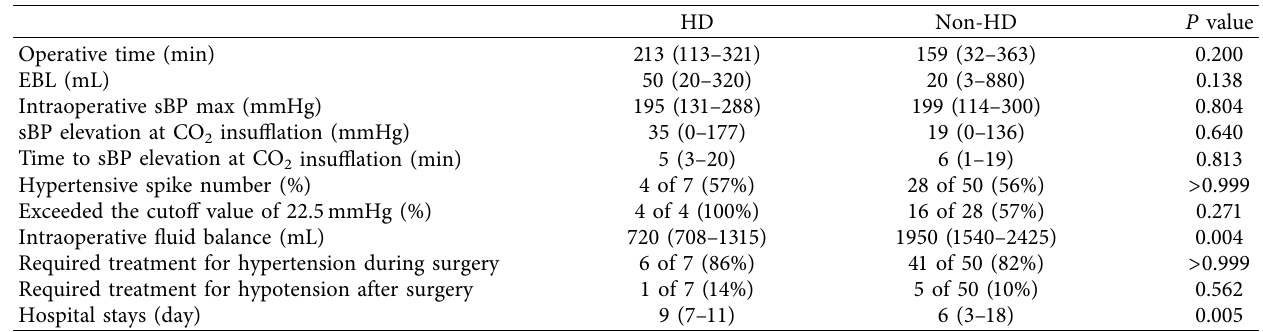
Table 3: Operative outcomes in the HD and non-HD patient groups.